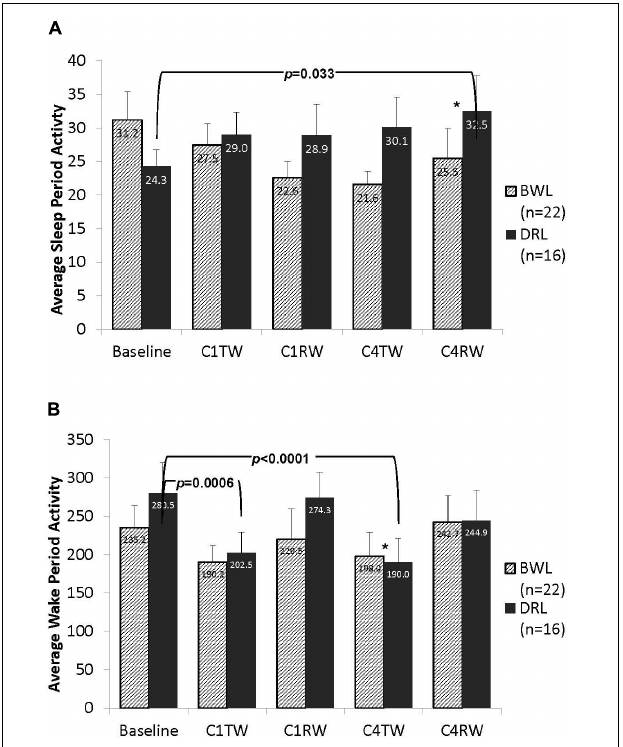
FIGURE 5 | Bar graphs depicting average counts per minute for both (A) the nighttime sleep period and (B) the daytime wake period activity in the BWL and DRL treatment groups from baseline through the TW and RW of chemotherapy cycles 1 and 4. As depicted in panel (A) , the average nighttime activity decreased in the BWL group while the DRL increased from baseline to the end of cycle 4 (C4RW). Conversely, as depicted in panel (B) , the average daytime activity decreased in the DRL group from baseline to the treatment weeks of cycle 1 (C1TW) and cycle 4 (C4TW). * p < 0.05 for group-by-time interaction, indicating that compared to DRL group, BWL group had significant less daytime activity decrease during